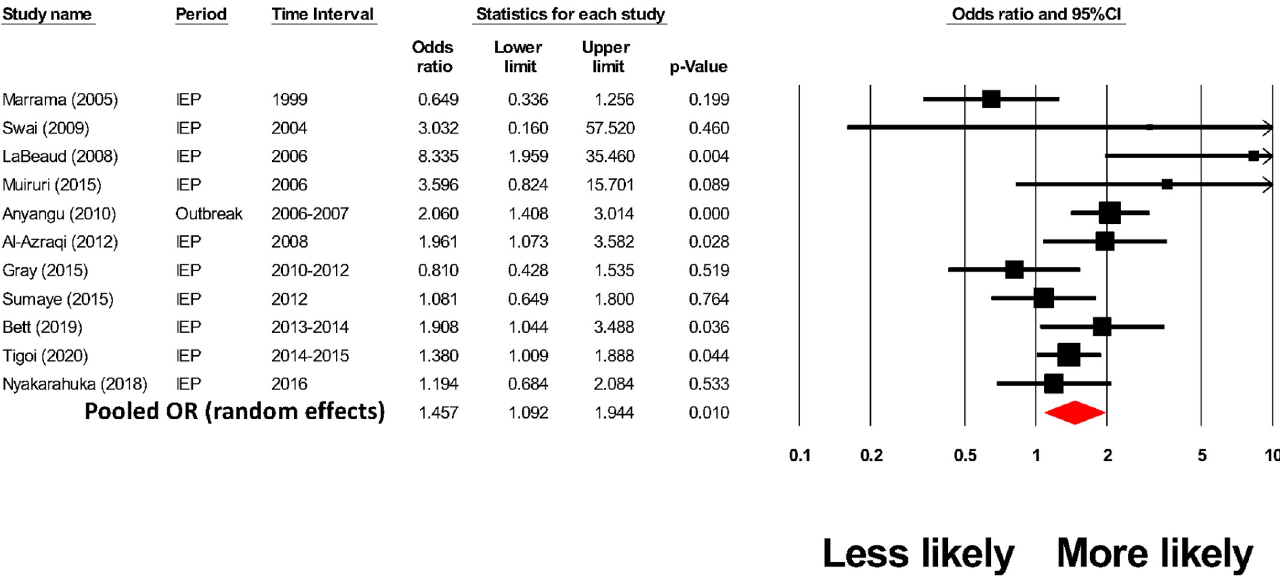
Fig 8. Meta-analysis of the impact of animal exposure on odds of RVFV exposure in at-risk populations.